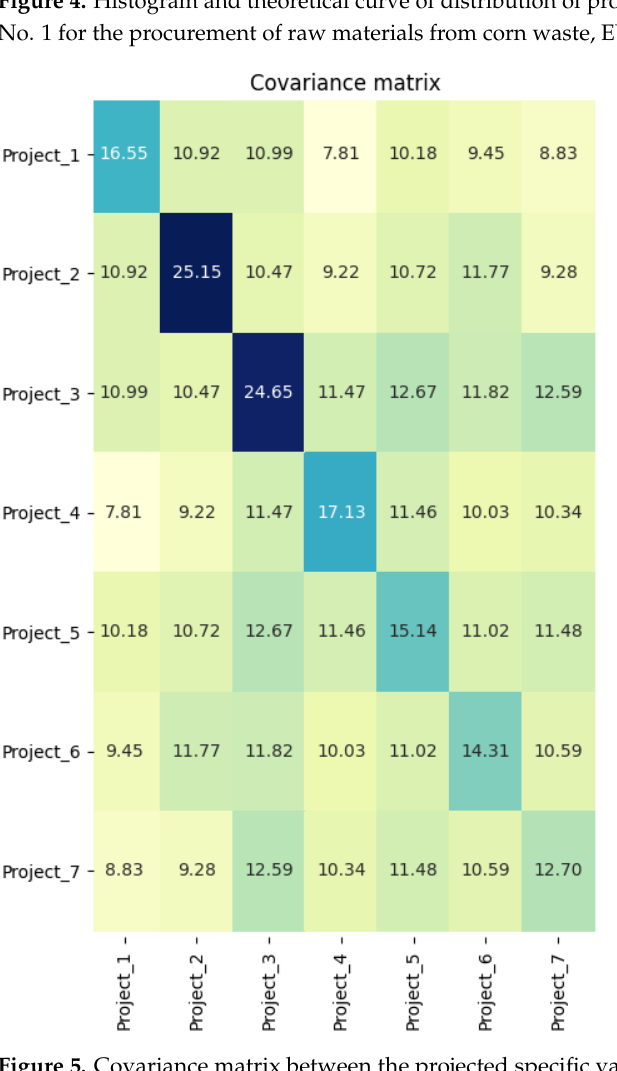
V ) of the individual projects нij R